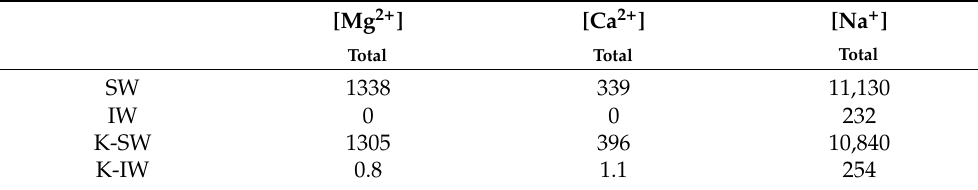
Table 2. Dissolved salts in SW, IW, and supernatant water in suspensions of kaolin in seawater (K-SW) and industrial water (K-IW).